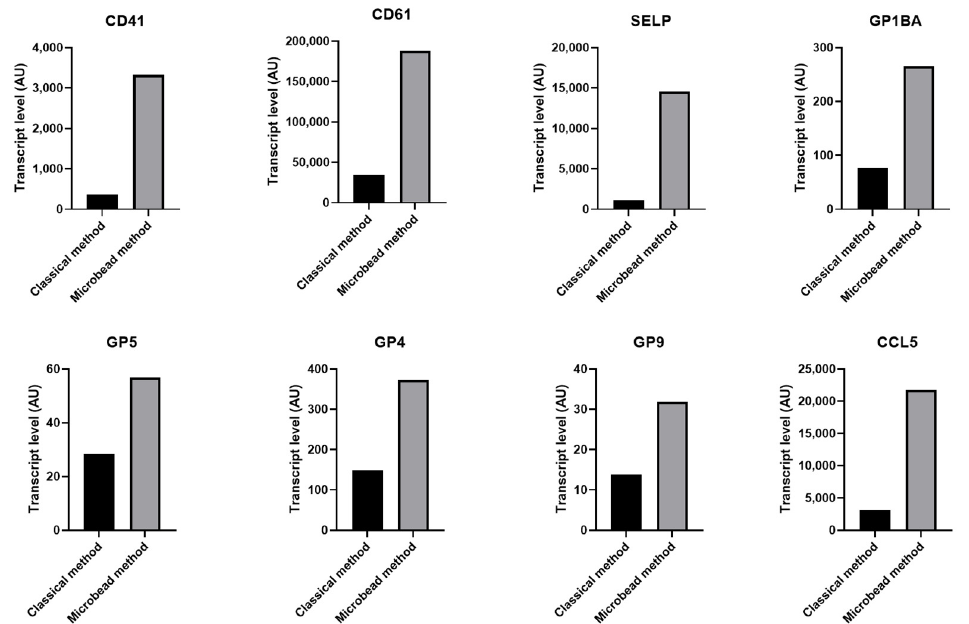
Figure 5. Decreased level of platelet related transcripts in the sample purified without magnetic microbeads. Histograms presenting transcript level for a number of platelet genes, detected by microarray in platelet preparations purified with or without magnetic microbeads.